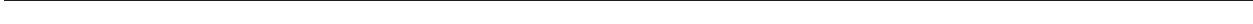
Fig. 2 FAAP24 and MHF are important for recruiting FANCM to Flex1 to prevent DSB formation and mitotic recombination. a DSB formation at Flex1 or Luc surrounding regions was analyzed by ChIP analysis of pCEP4-Flex1 or pCEP4-Luc 10 using H2AX-S139p ( γ H2AX) antibody. Anti- γ H2AX ChIP was performed in U2OS cells expressing FANCM shRNA (left), expressing Flag-FANCM-WT or K117R with endogenous FANCM silenced by shRNA (middle), or expressing FAAP24 shRNA with or without HU treatment (2 mM, 6 h) (right). Western blots for the expression of FANCM, Flag-FANCM WT and K117R, and FAAP24 are shown in Supplementary Fig. 5b. b Flag-FANCM or empty vector (Ctrl) was expressed in U2OS (HR-Flex) reporter cell line with Flex1 stably integrated into the genome. Anti-Flag ChIP was performed using indicated primer sets (P1 or P2), or primers corresponding to GAPDH (left); or using P1 before or after APH treatment (0.4 μ M, 24 h) (right). ChIP value in Ctrl is set up as 1 for normalization. c Anti-Flag ChIP at Flex1 was performed in U2OS (HR-Flex) cells expressing Flag-FANCM and shRNAs for FAAP24 (left) or MHF1 (right) with vector as a control. Western blots for the expression of FAAP24 and MHF1 are shown in Supplementary Fig. 5d. d Spontaneous recombination was assayed in U2OS (HR-Flex) cells expressing shRNA for FAAP24 (left) or MHF1 (right) with a vector control. e Anti-Flag ChIP at Flex1 was performed in U2OS (HR-Flex) cells expressing Flag-FANCM-WT or indicated mutants with the vector as a control. Western blots showing FANCM expression are in Supplementary Fig. 5e. f Anti-Flag ChIP at Flex1 was performed in U2OS (HR-Flex) cells expressing Flag-FAAP24 WT or mutants (left), or Flag-FANCM and HA-FAAP24 WT or indicated FAAP24 mutants with endogenous FAAP24 silenced by shRNA (right). ChIP in the vector expressing cells serves as the control. DB DNA binding mutant: K171A/K173A; MB FANCM binding mutant: V198A/V199A/G200A. Western blots showing relevant protein expression are in Supplementary Fig. 5f, g. g Spontaneous recombination was assayed in U2OS (HR-Flex) cells expressing Flag-FAAP24 WT and mutant alleles with endogenous FAAP24 silenced by